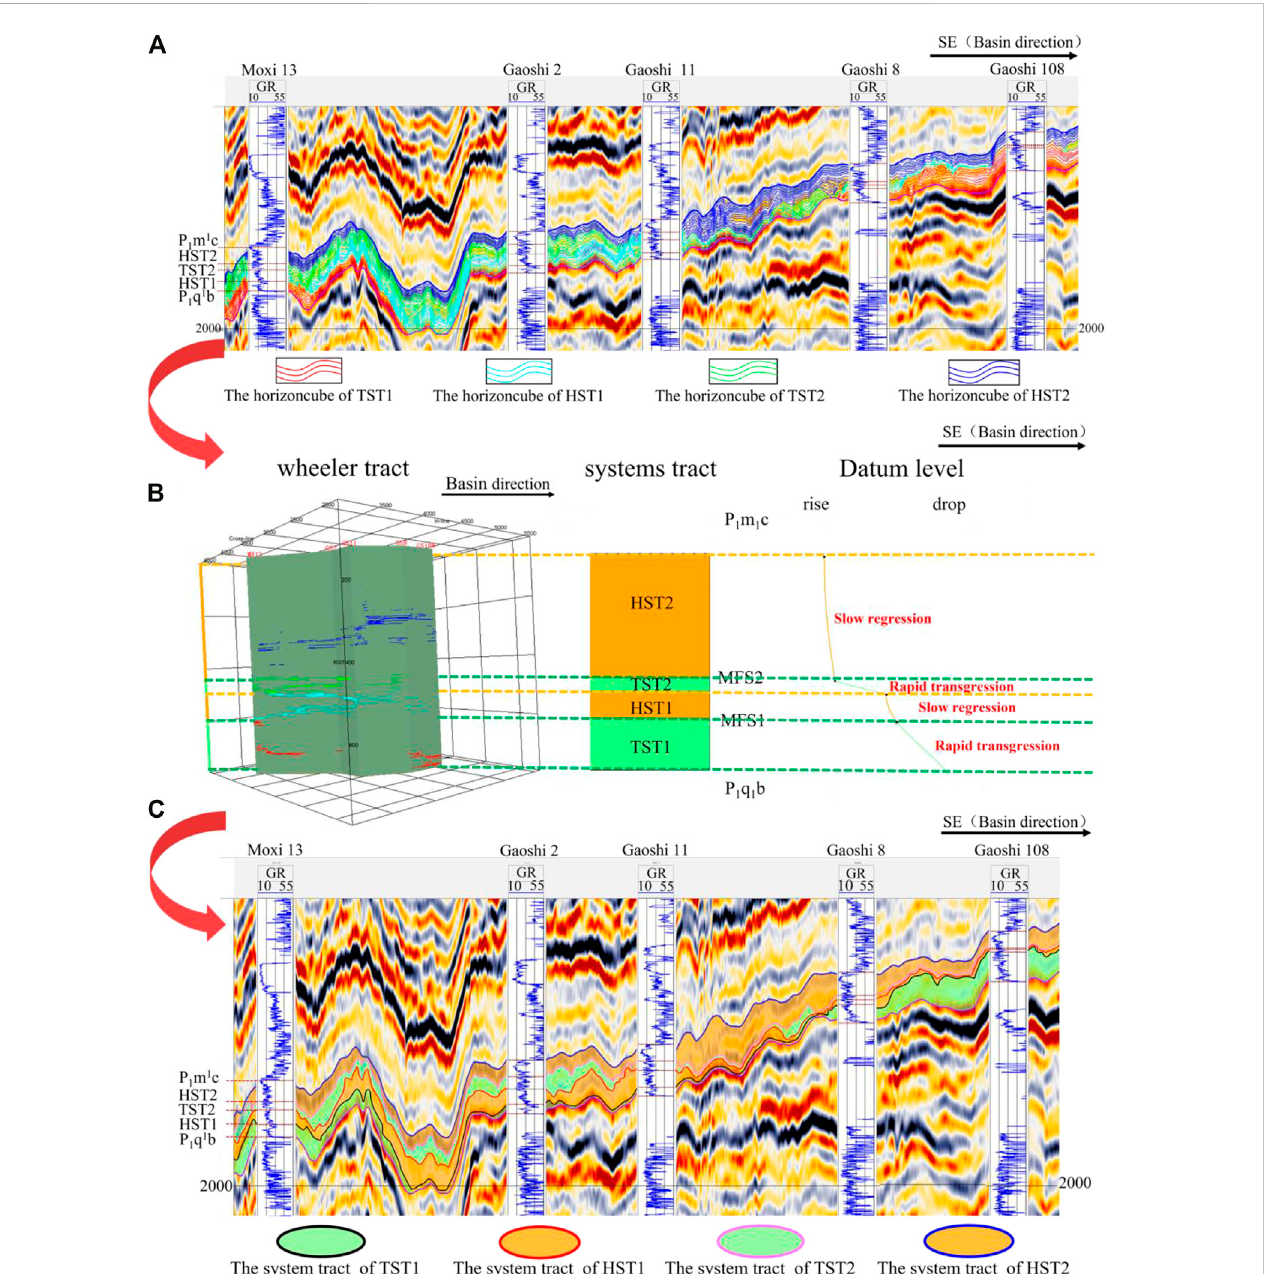
FIGURE 6 (A) Comparison ofMoxi13-Gaoshi2-Gaoshi11-Gaoshi8-Gaoshi108 ( ① )well connection seismicpro fi le oftheQixiaFormation horizon.See Figure 1Bfor the plane position of the pro fi le shown in the fi gure; (B) Diagram explaining the Moxi13-Gaoshi2-Gaoshi11-Gaoshi8-Gaoshi108 ( ① ) well frame system; (C) System comparison of the Moxi13-Gaoshi2-Gaoshi11-Gaoshi8-Gaoshi108 ( ① ) well frame seismic pro fi le. See Figure 1B for the plane position of the pro fi le shown in the fi